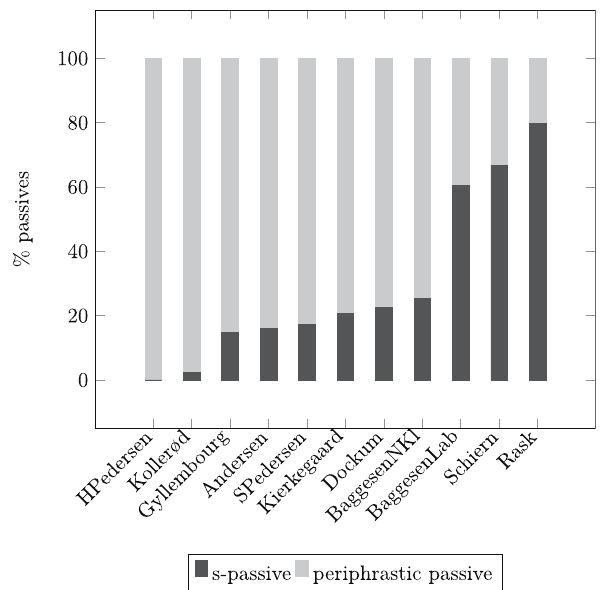
Figure 1: Shares of past - tense passives in the